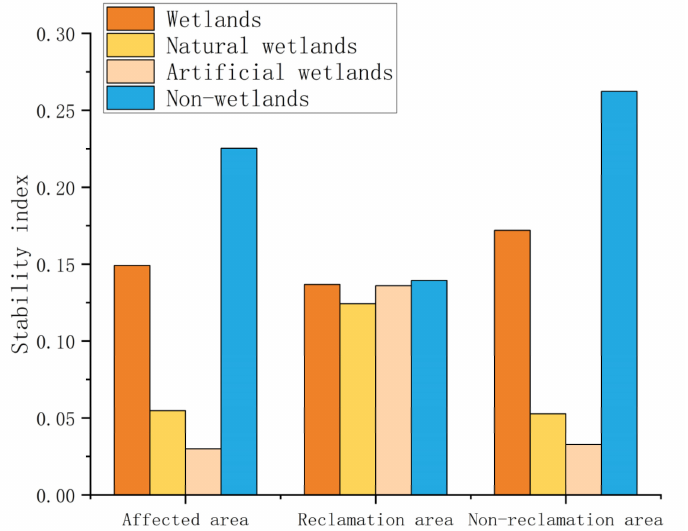
Figure 6. Stability index of different wetland types in different regions.